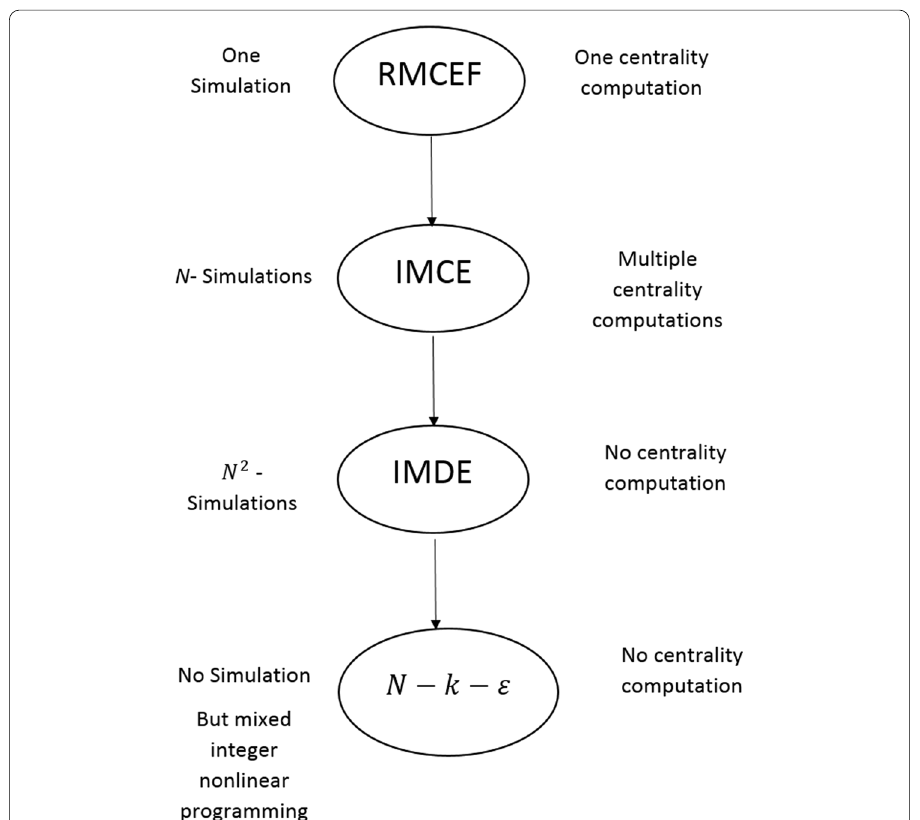
Fig. 10 Approaches in order increasing